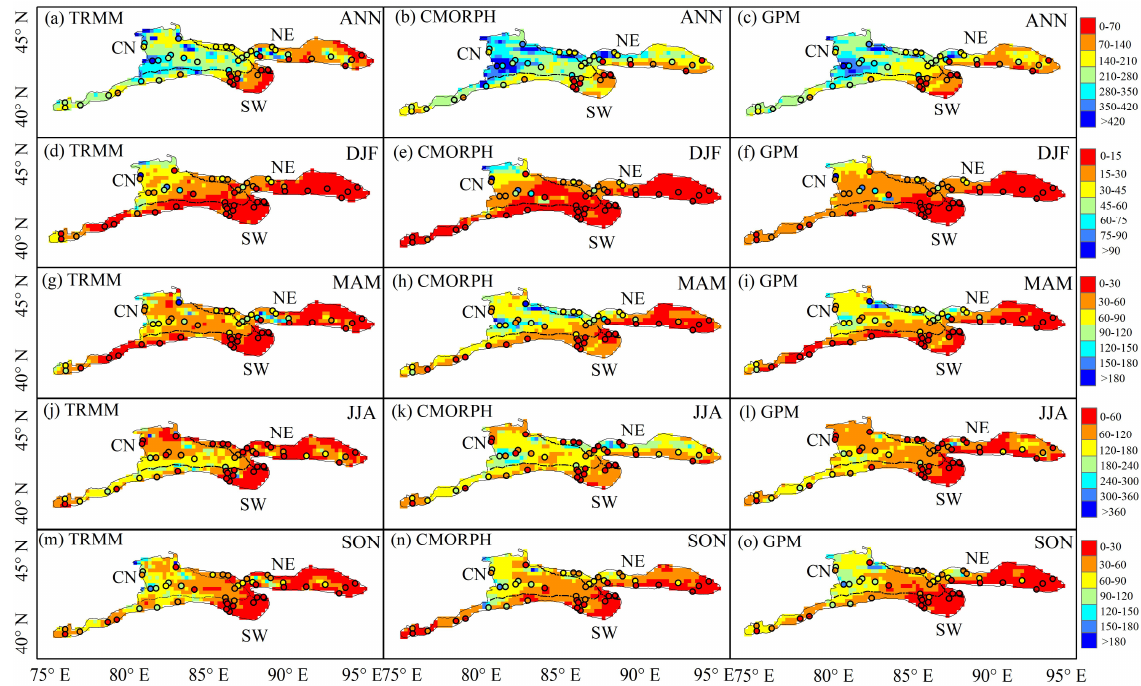
Figure 4. Spatial patterns of the observed precipitation (mm) by the gauge stations (circles) and the satellite estimated precipitations estimated by the TRMM ( a , d , g , j , m ), CMORPH ( b , e , h , k , n ), and GPM ( c , f , i , l , o ) at annual and seasonal scales. ANN: annual ( a – c ), DJF: winter ( d – f ), MAM: spring ( g – i ), JJA: summer ( j – l ), SON: autumn ( m – o ). CN: Central Tianshan area, NE: northeastern Tianshan area, SW: southwestern Tianshan.